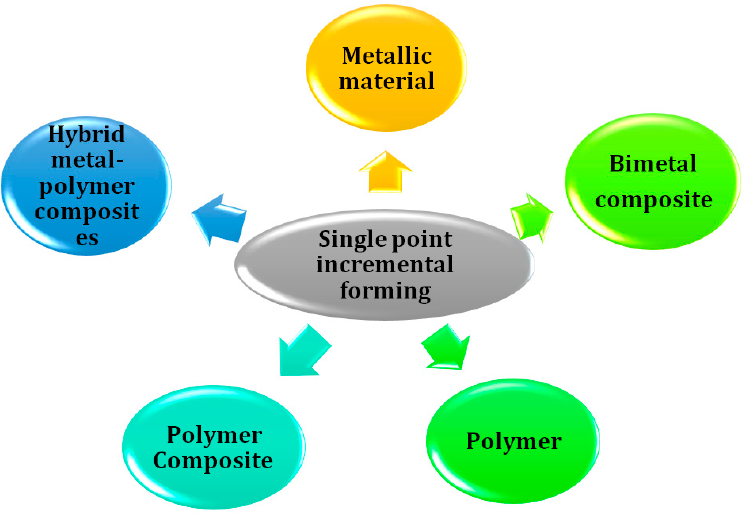
Figure 16. Materials used in the SPIF process.